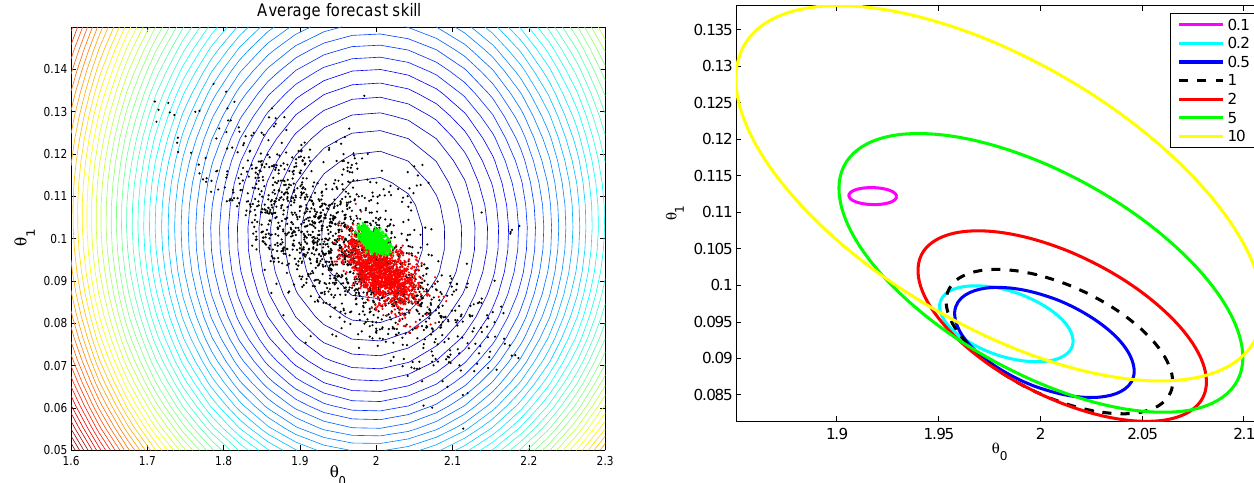
Fig. 7. An illustration of the average forecast skill. Black, red and green dots indicate the results from 10, 50 and 500 day MCMC simulations, respectively. Blue contour colors indicate high forecast skill.